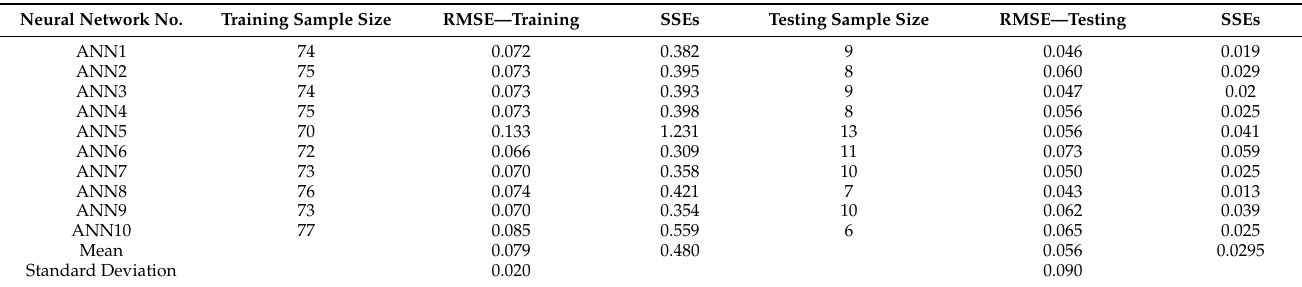
Table 11. Model A Predictive accuracy.